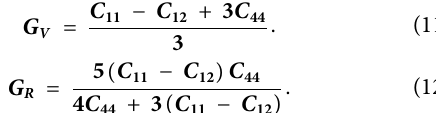
Frontiers in Materials |